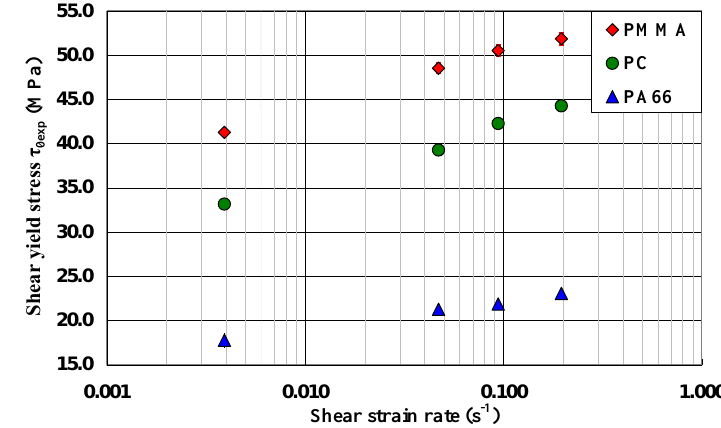
Figure 9. Yield shear stresses τ strain rate  .